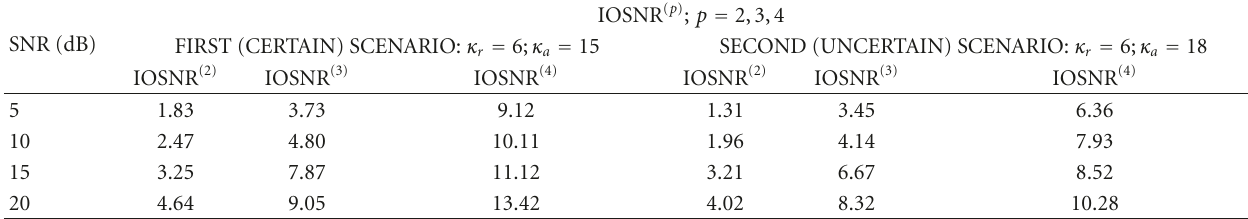
Table 2: IOSNR values providedwith three simulated DEDR-related methods, p = 2, 3, 4 (2) adaptive despeckling filter; (3) DEDR-RSF; (4) DEDR-RASF; results are reported for the certain and uncertain simulated